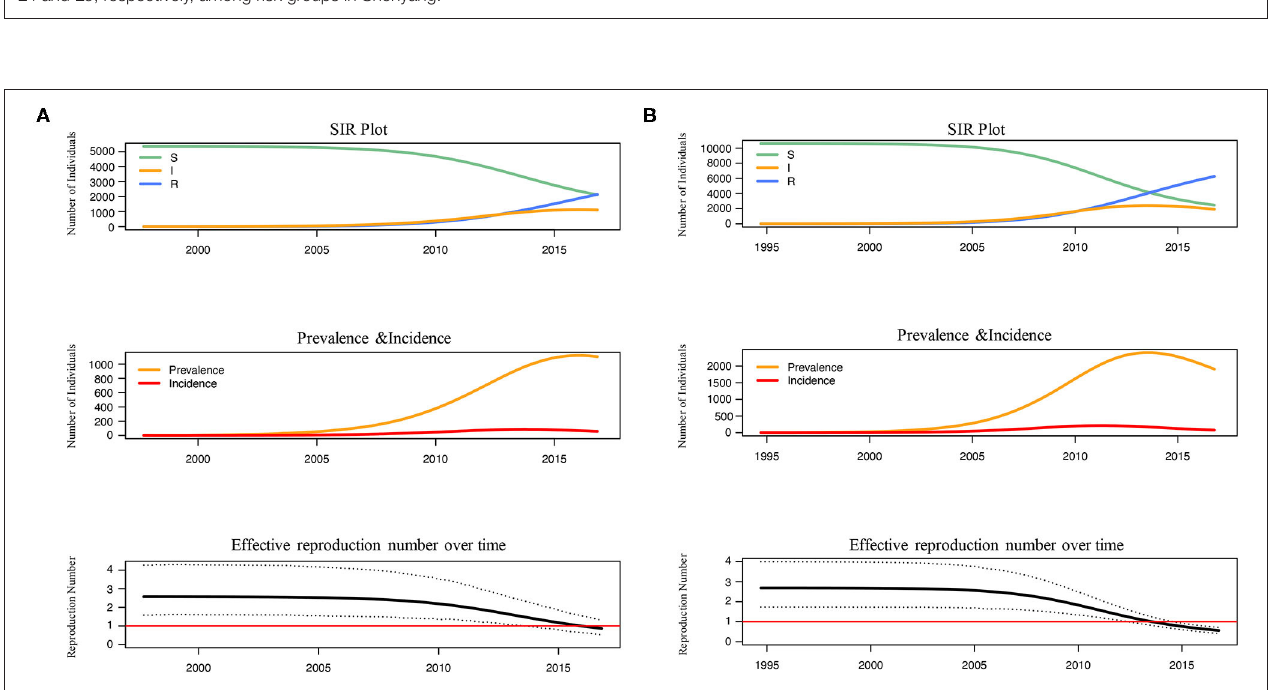
FIGURE 2 | The viral migration events between risk groups in Shenyang, based on a Bayes Factor > 10. BF > 10 is a strong support for observed migration events; therefore, the migration events with BF > 10 are shown between risk groups. The left and right sides represent the source and recipient of migration events, respectively. The fractions for each side represent the proportions of migration events from the sources toward the recipients. (A,B) represent the viral movements of L4 and L5, respectively, among risk groups in Shenyang.